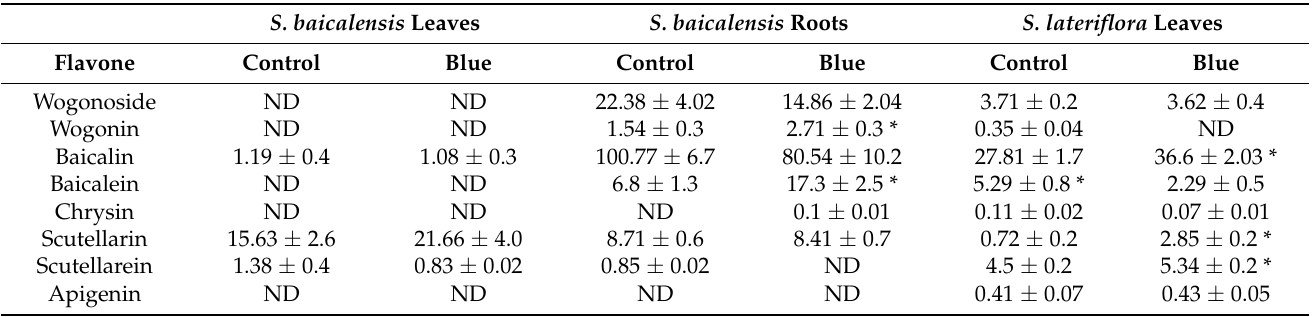
Data are presented as means ± standard errors reported in mg · g − 1 of dry weight. * Indicates values that are significantly different (Students t test, p ≤ 0.05). Statistical analysis was performed for each metabolite within species and tissue types. ND = not detected as levels are below detectable